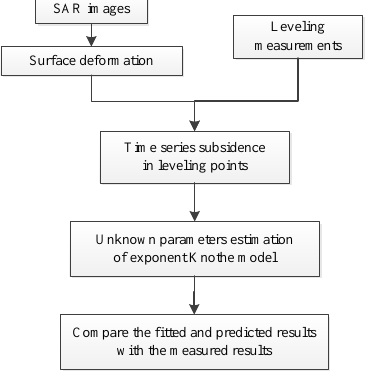
Figure 3. The block diagram of the used method